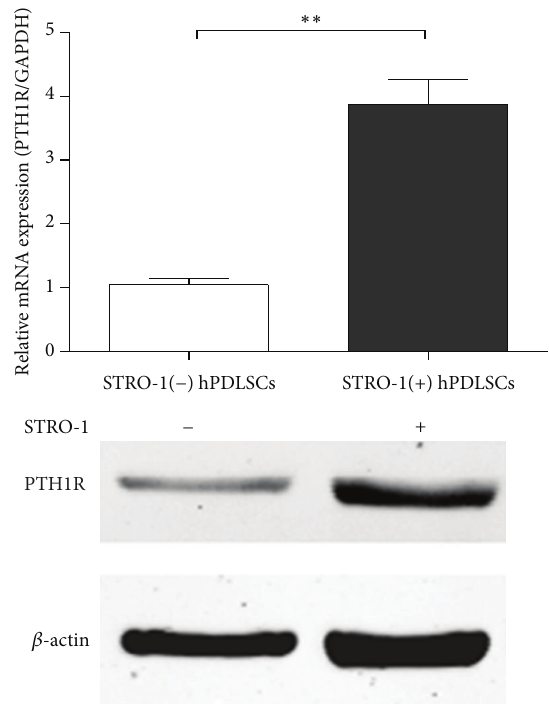
Figure 3: Real-time PCR and western blot analyses of PTH1R expression in STRO-1( − ) and STRO-1(+) hPDLSCs. The expression of each target was normalized to that of GAPDH. Data are presented as means ± SDs of three independent experiments performed in duplicate. ∗∗ 𝑃 < 0.01